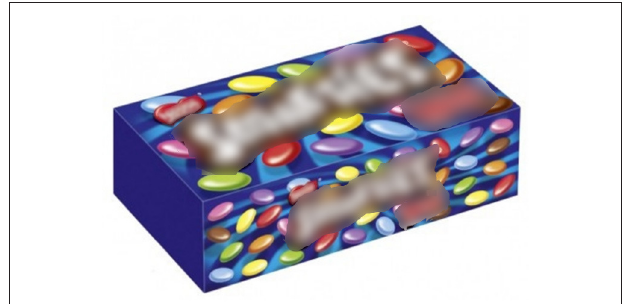
FIGURE 2 | The Smarties box used for object B in WCF, WCK, and KCF